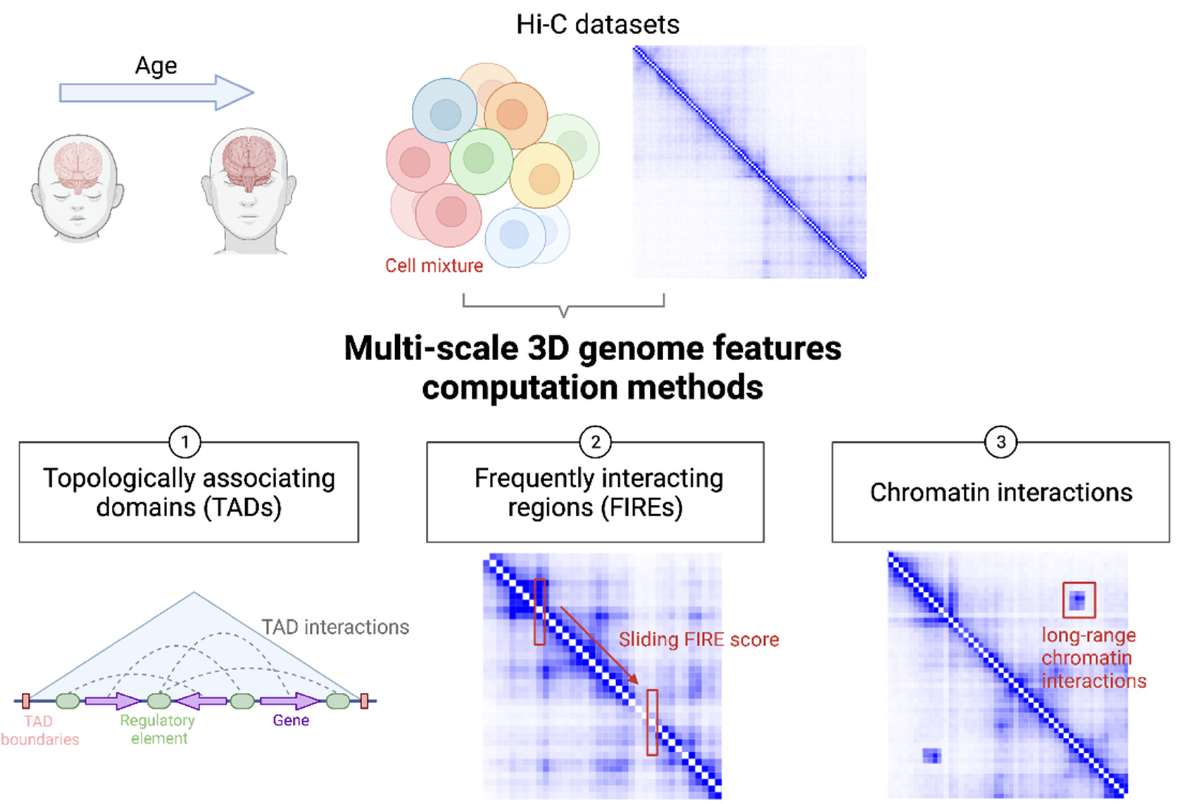
Figure 1. Cartoon illustration of utilizing brain 3D genome organization data at multiple scales to understand genetic mechanisms of brain function and disease. Hi-C and like datasets can be generated from brain samples from donors at different ages. Typically, each sample contains a mixture of different brain cell types. From a typical Hi-C dataset, TADs, FIREs, and chromatin interactions can be defined at different developmental stages and from distinct cell types for comparative analysis.